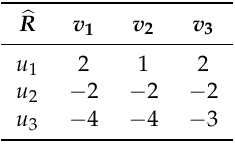
Table 1. Comparison matrix of ( (cid:98) R ) .